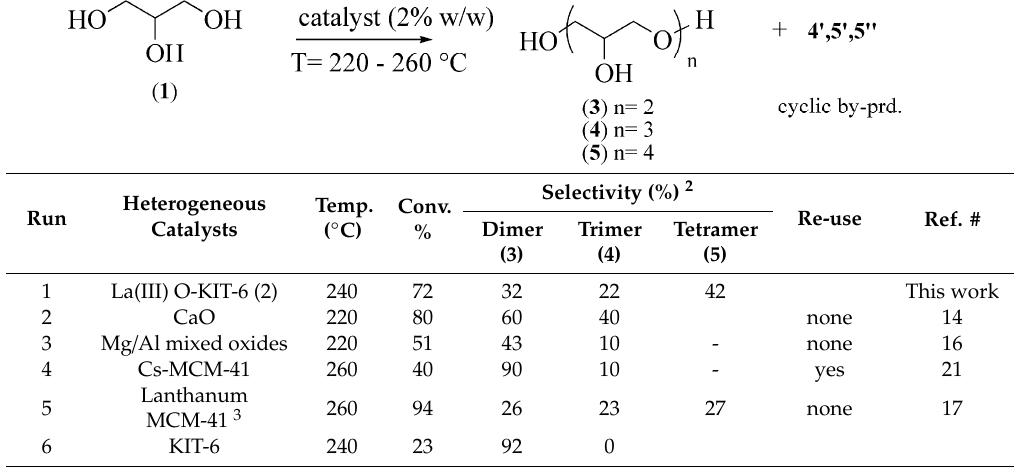
Table 3. Comparison of efficiency of heterogeneous catalyst in glycerol linear oligomerization. 1